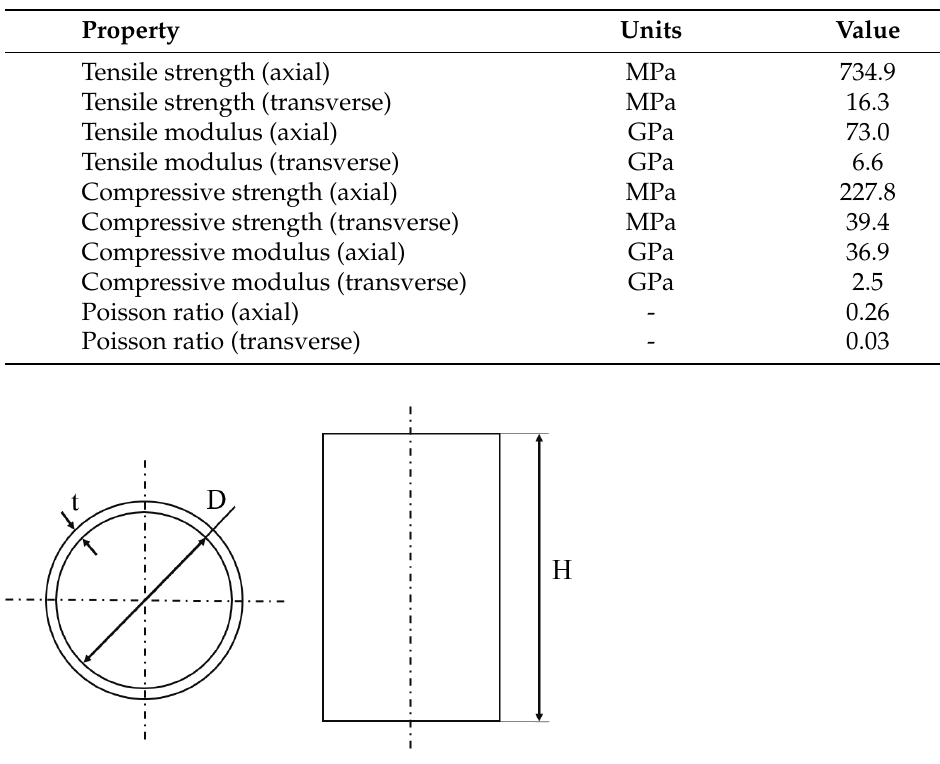
Table 2. Mechanical properties of the CFRP tube’s base material.